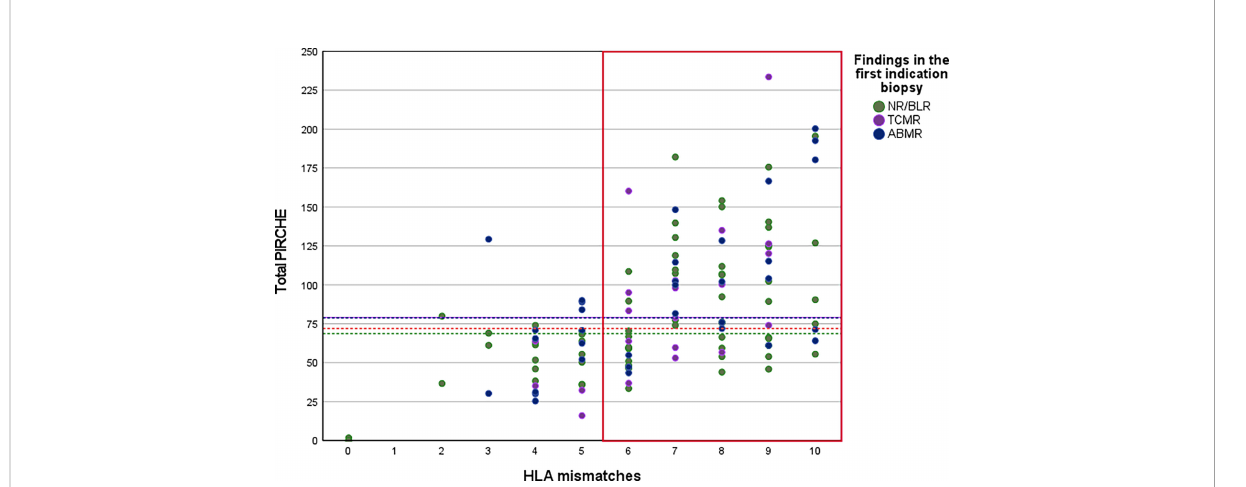
FIGURE 2 Distribution of total PIRCHE-II scores compared to total HLA-mismatches. PIRCHE-II scores and the number of HLA mismatches were calculated from HLA class I (HLA-A, B, C) and HLA class II (HLA-DR, DQ) mismatches. Median PIRCHE-II scores for Group NR/BLR, Group TCMR, and Group ABMR were 68.66, 79.03, and 79.99, respectively.